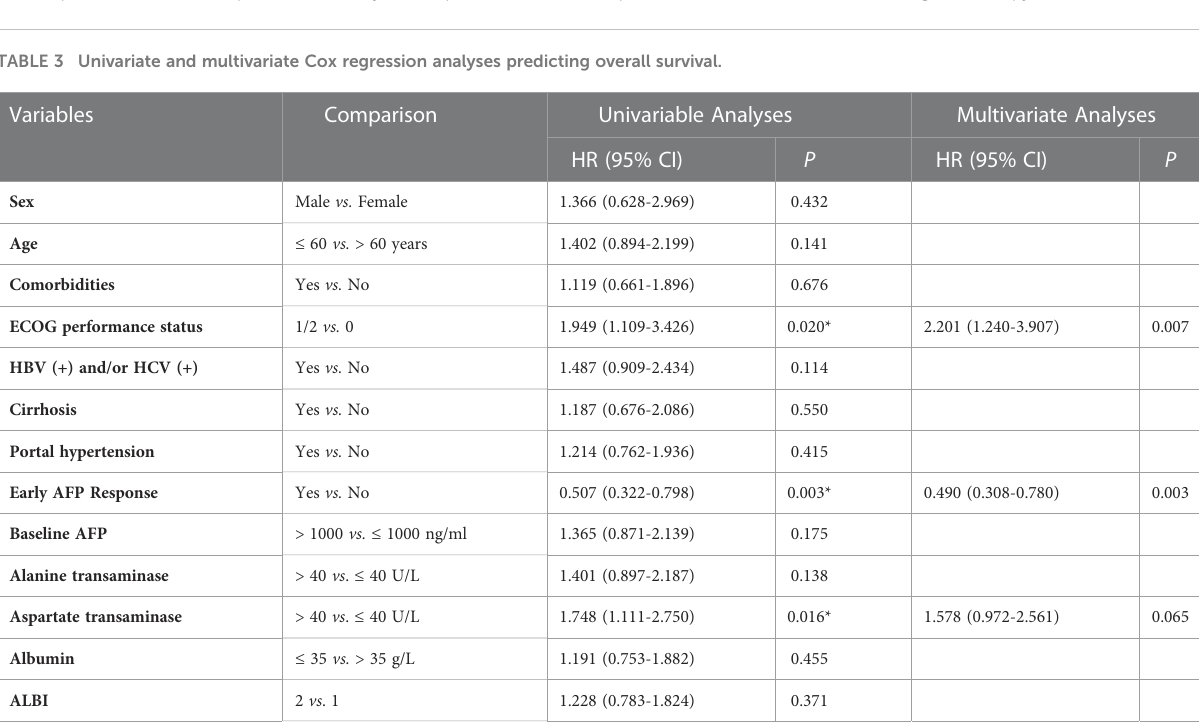
FIGURE 4 Cumulative incidence of overall survival (A) and progression-free survival (B) curves comparisons between the patients with AFP response and no AFP response in the targeted agents ’ cohort. Cumulative incidence of overall survival (C) and progression-free survival (D) curves comparisons between the patients with early AFP response and no AFP response in the immune combination targeted therapy cohort.